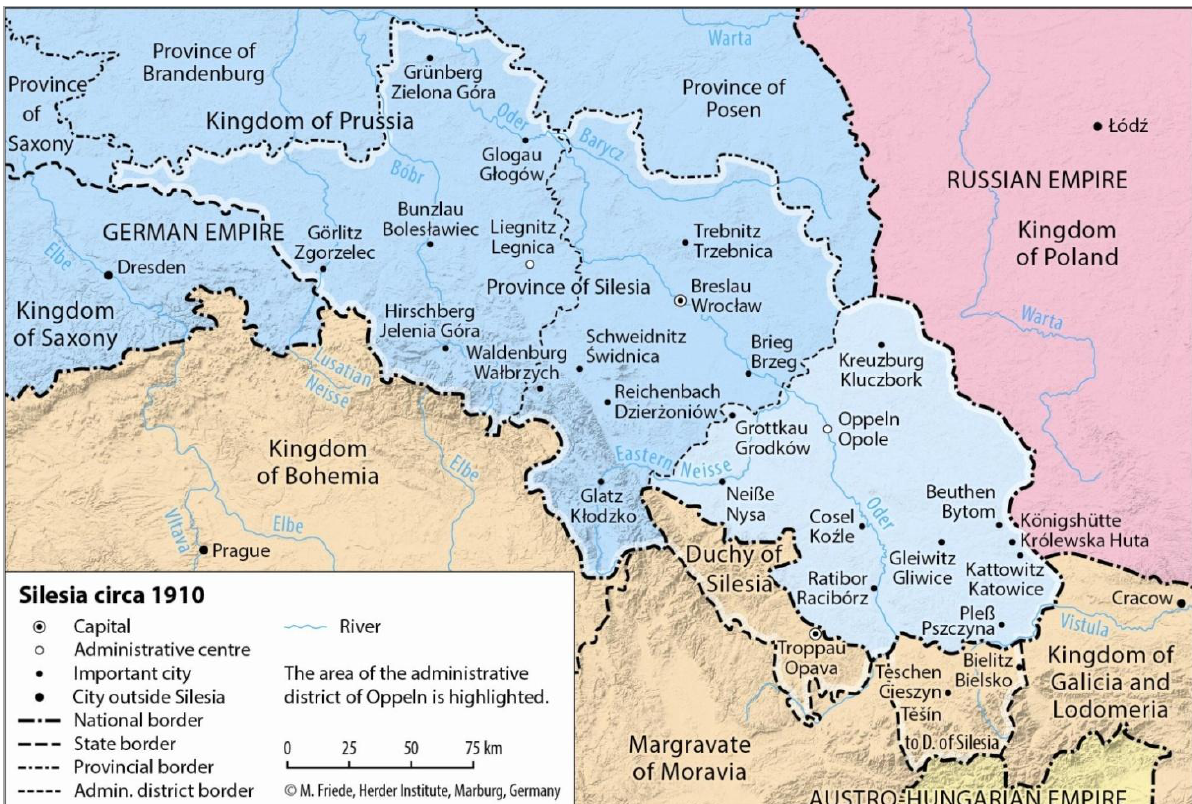
Fig. 1. Location of the district of Oppeln within the province of Silesia (after Marc Friede, Herder Institute,